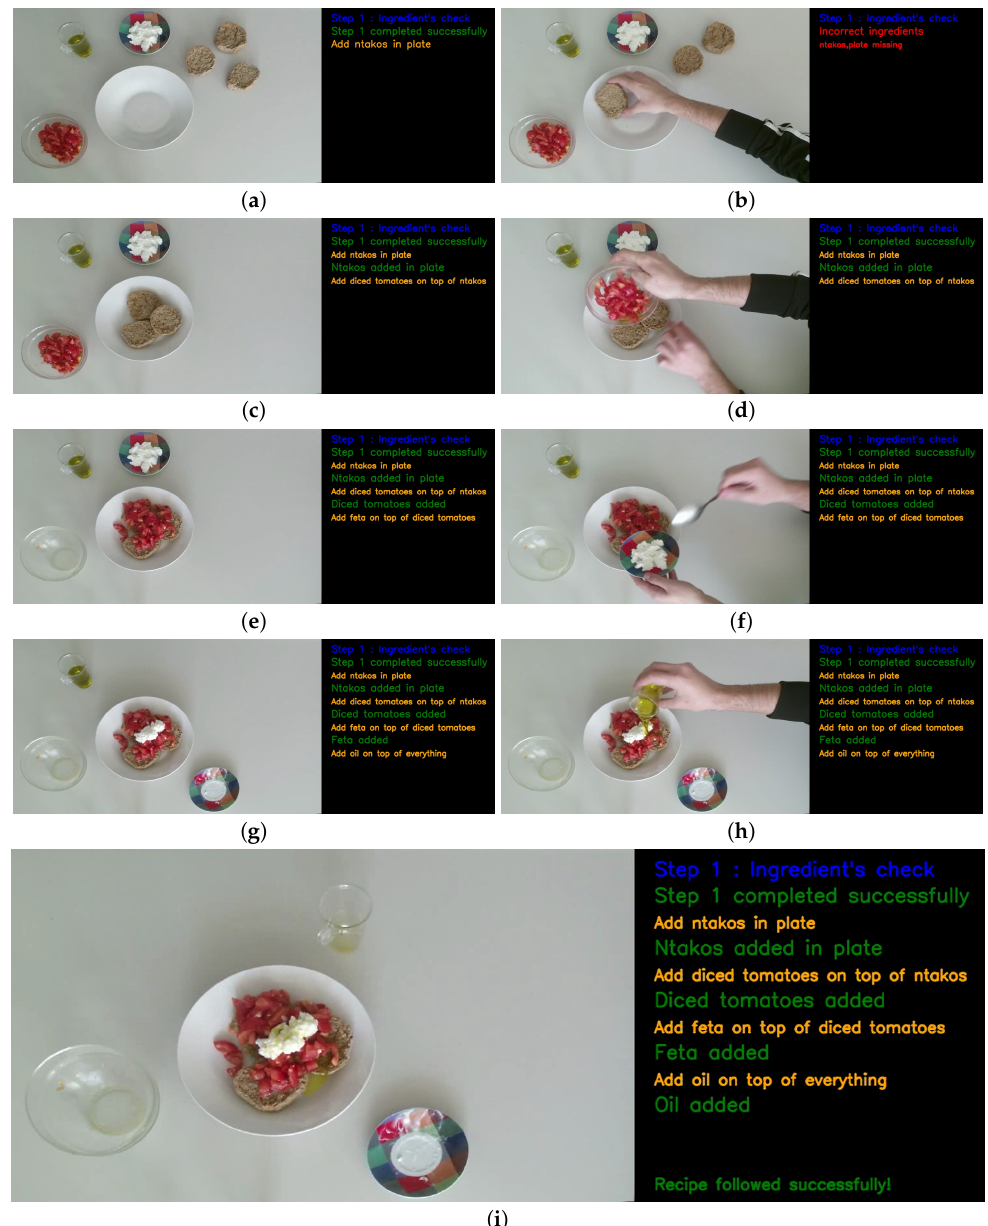
Figure 12. Cooking procedure of Greek Ntakos: ( a ) first step: add ntakos, ( b ) moving ntakos; ( c ) second step: add diced tomatoes, ( d ) moving tomatoes; ( e ) third step: add feta, ( f ) moving feta; ( g ) fourth step: add oil, ( h ) moving oil; ( i ) successful execution of the